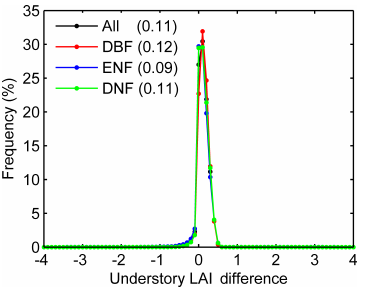
Figure 2. Frequency of differences of derived understory LAI based on the GLOBCARBON algorithm between shrub and grass.